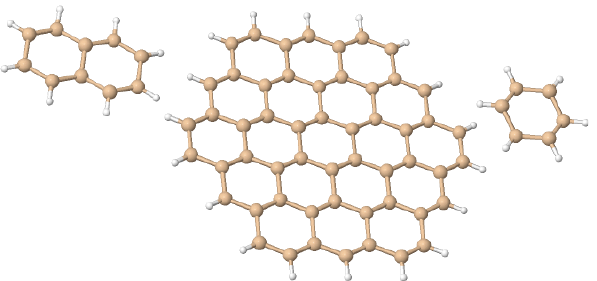
Figure 4. The “silicene flakes” considered in Table 1. From left to right, Si 10 –naphatelene, Si 54 – circumcoronene and